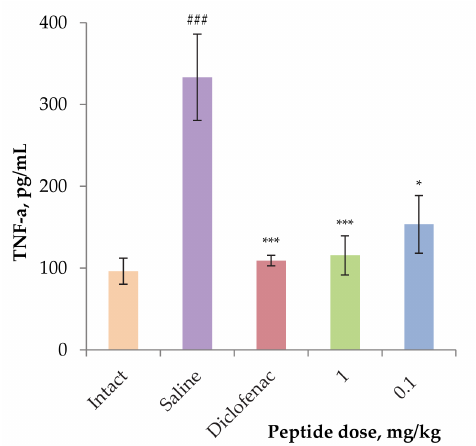
Figure 5. The level of TNF- α in the blood serum of experimental animals. Blood samples were obtained 24 h after induction of inflammation by carrageenan. Results are presented as mean ± SD (n = 7–8). The significance of differences was estimated by the Student’s t -criterion to the saline group (*) and to the intact serum (#). Significant differences are presented as * p < 0.05, *** p < 0.001, and ### p ≤